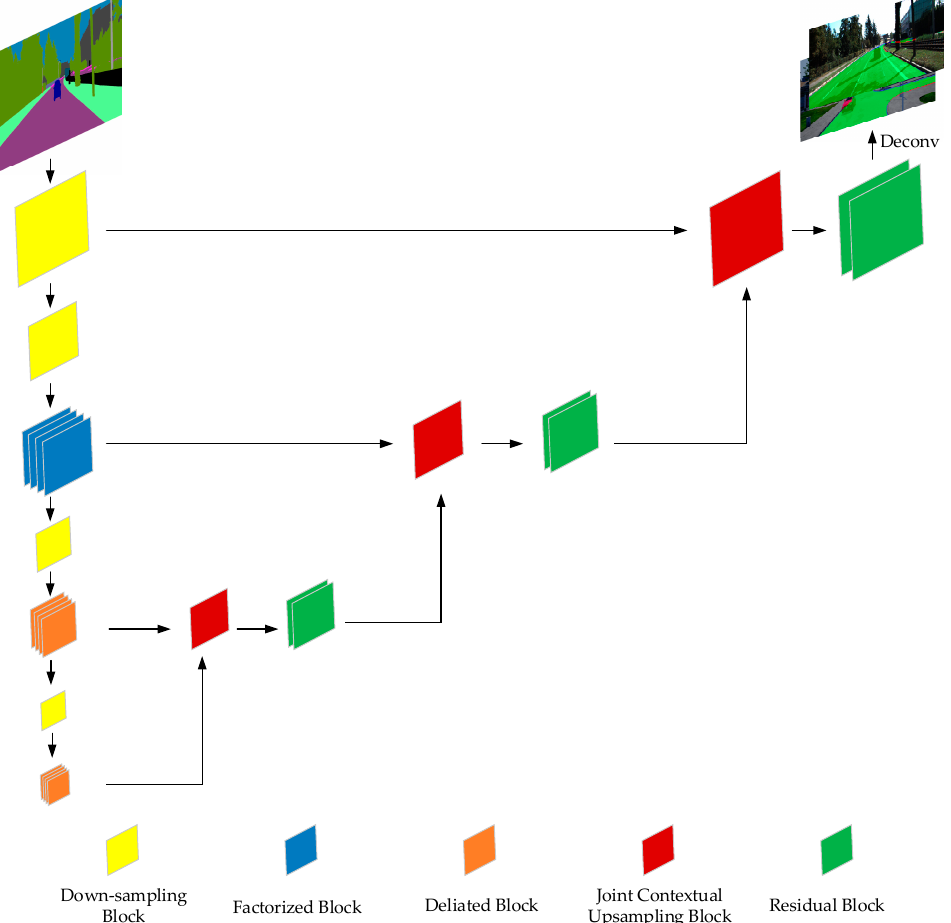
Figure 2. The proposed occlusion-free road segmentation network architecture.